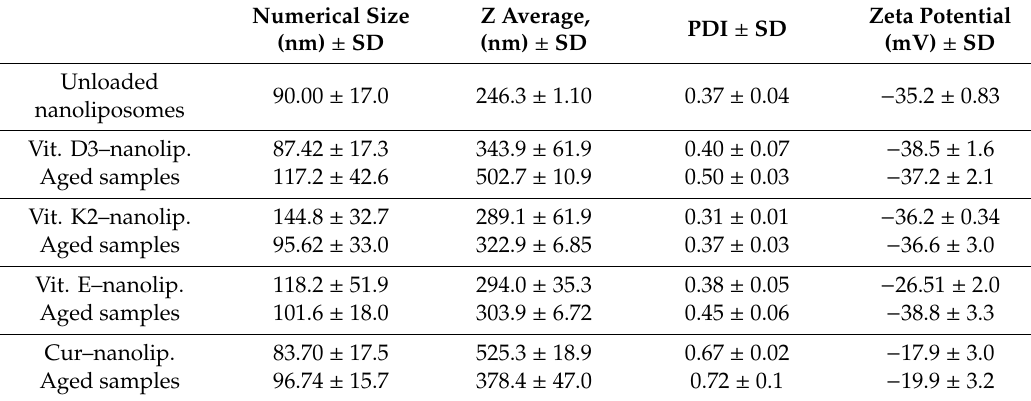
Table 1. Numerical size, Z-average, polydispersity index (PDI), and zeta potential of unloaded vesicles and nanoliposomes loaded with vitamin D3, vitamin K2, vitamin E, and curcumin at time zero and after 1 month storage (aged samples) at 4 ◦ C. Results are expressed as average of three determinations and reported along with the standard deviation